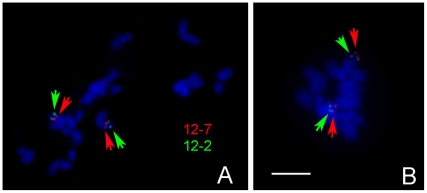
An inversion detected by FISH on cucumber chromosome 5 between GY 14 and PI183967.(A) Locations of the fosmid 12-7 (SSR20648, red) and 12-2 (SSR13340, green) on chromosome 5 of GY14. Red signals are located closer to the telomere than green signals. (B) Locations of the fosmid clones on chromosome 5 of PI 183967. Note that green signals are closer to the telomere. Bars = 3 µm.